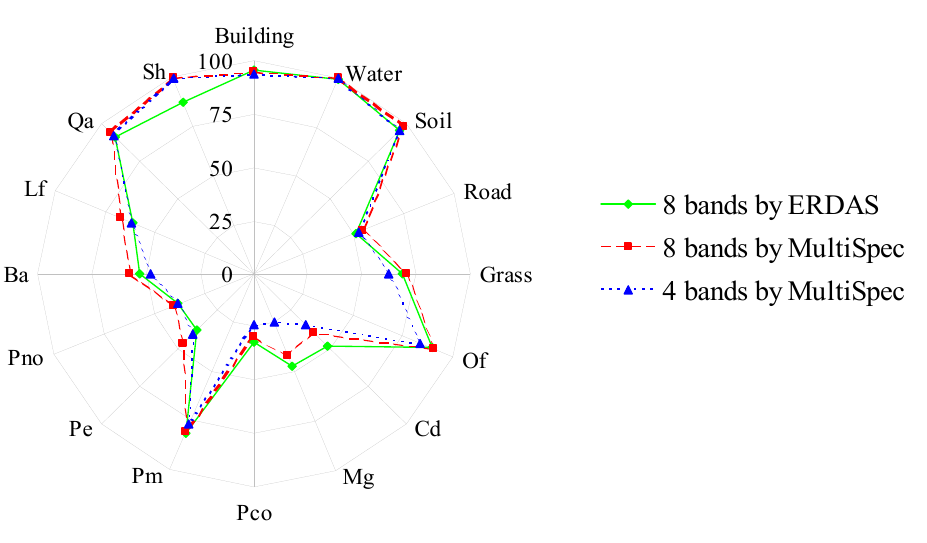
Figure 7. Spider chart representing the user accuracies for different classification approaches. The abbreviations are the same as in Figure